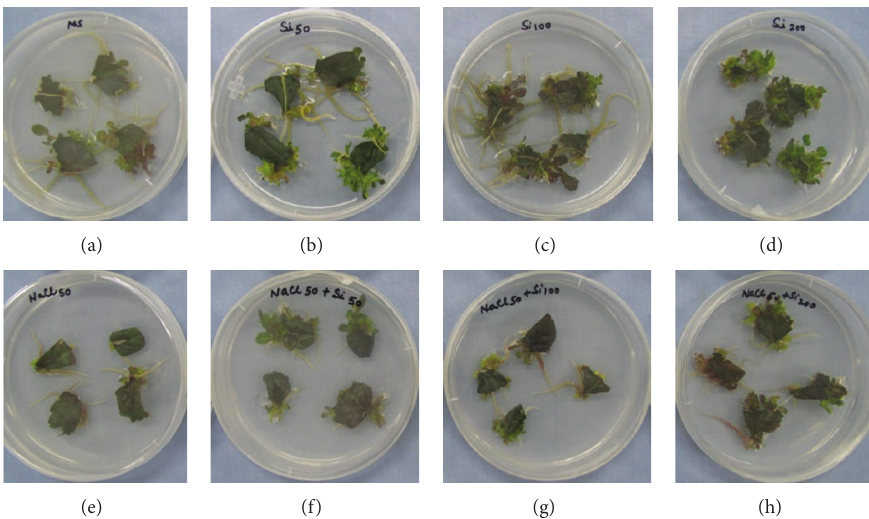
Figure 1: Effect of silicon and NaCl on adventitious shoot regeneration from leaf explants of A. multiflora . (a) MS medium with 12.2 𝜇 M 2iP and 5.7 𝜇 M IAA (SIM), (b) SIM + 1.8 mM Si, (c) SIM + 3.6 mM Si, (d) SIM + 7.2 mM Si, (e) SIM + 50 mM NaCl, (f) SIM + 50mM NaCl +